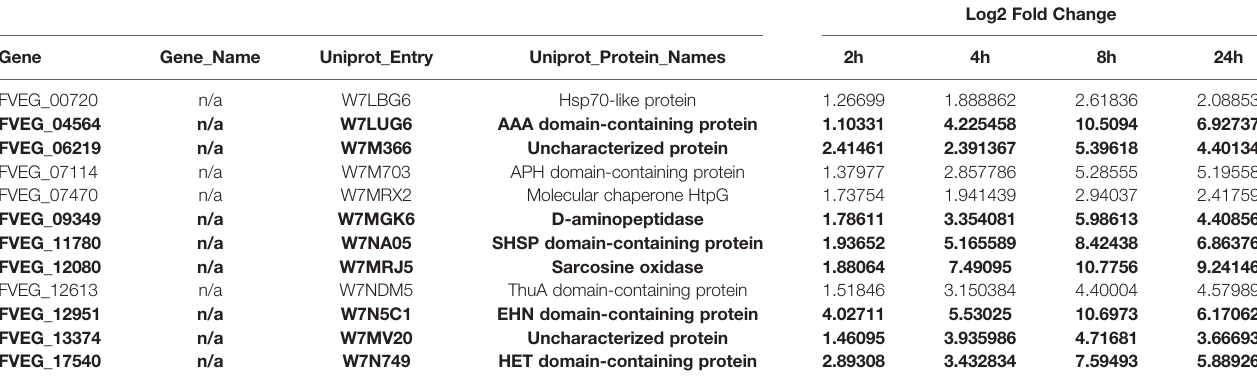
TABLE 2 | Common differentially expressed genes for s2831 dual-cultures across all time